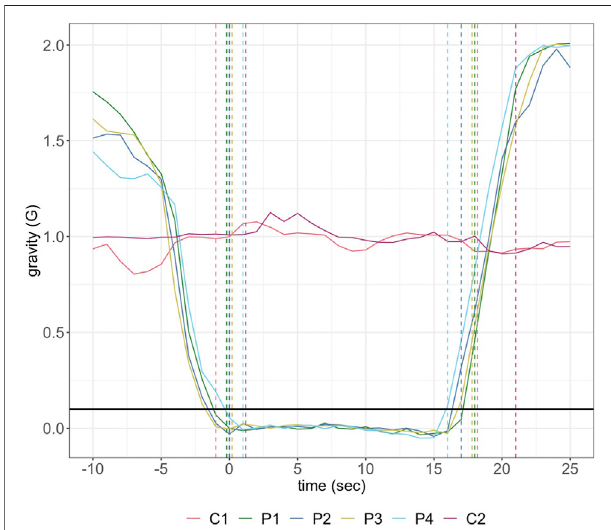
FIGURE 1 | Gravitational load over the time-course of the control (C1, C2) and parabolic (P1 – P4) reactions completed during fl ight. The fi rst and second sets of dashed lines represent the start and end of each reaction, respectively. The reaction initiation threshold of 0.1 G is shown in black across the period.